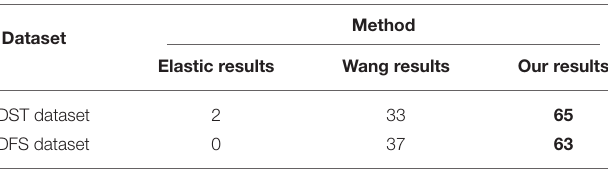
TABLE 1 | The scores of the subjective evaluation of Drosophila ssTEM (DST) and Drosophila FIB-SEM (DFS)